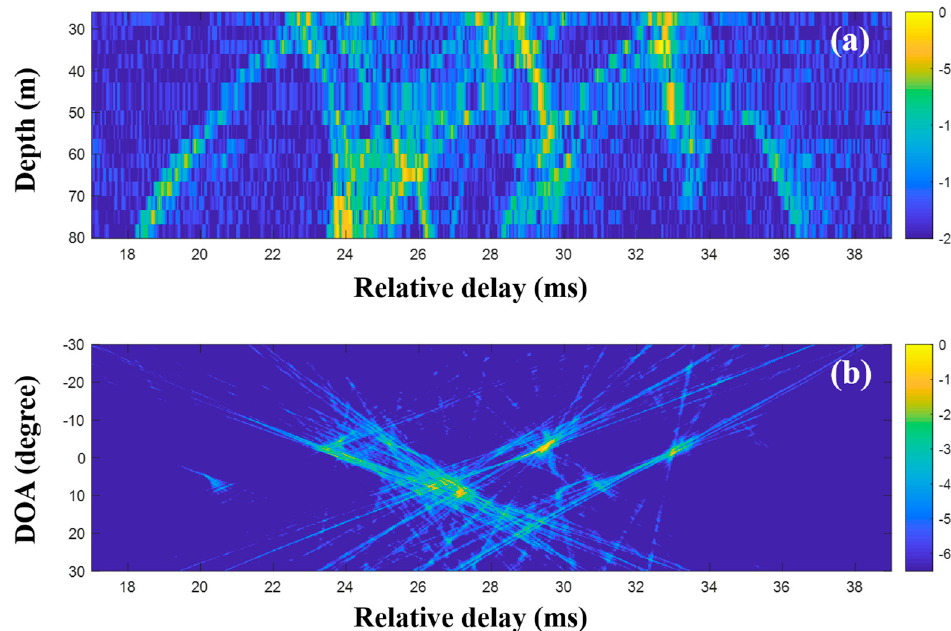
Figure 13. Direction-of-arrival (DOA) estimation using the matched filter (MF) with a single snapshot captured by the vertical line array (VLA) in SAVEX15 (11–31 kHz): ( a ) arrival structures via the application of the MF to the signals at the VLA and ( b ) DOAs using delay-and-sum beamforming with the arrival structures.